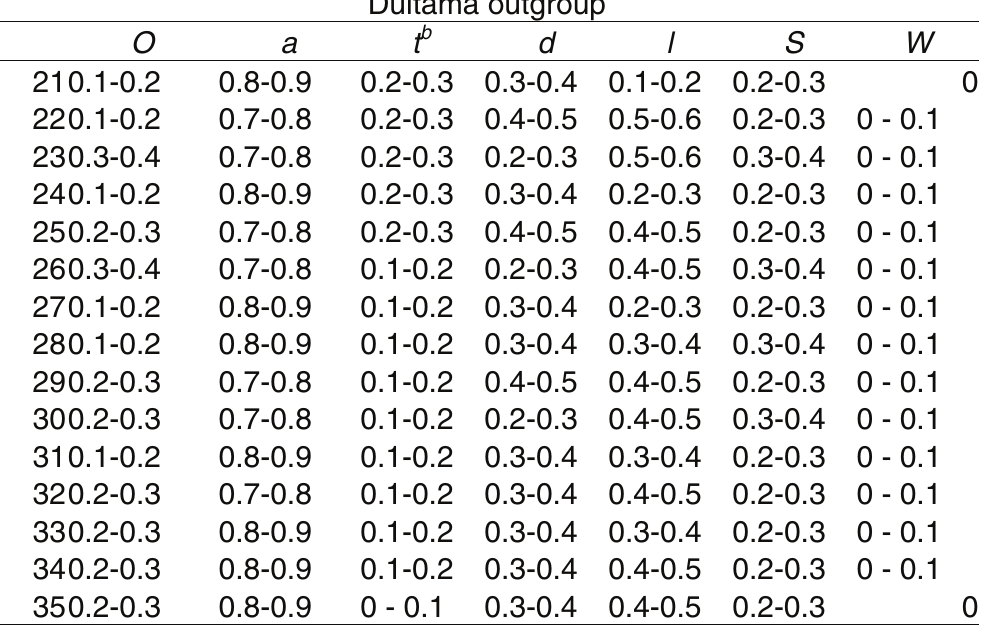
Table S3. Allele frequencies of ancestral populations (nodes) of several Latin American cat populations estimated by means of maximum parsimony trees for the alleles O, a , t b , d, l, S, and W, with (a) the population of Duitama as outgroup and (b) Leticia-Tabatinga as outgroup. Numbers are the nodes of the trees of Figure